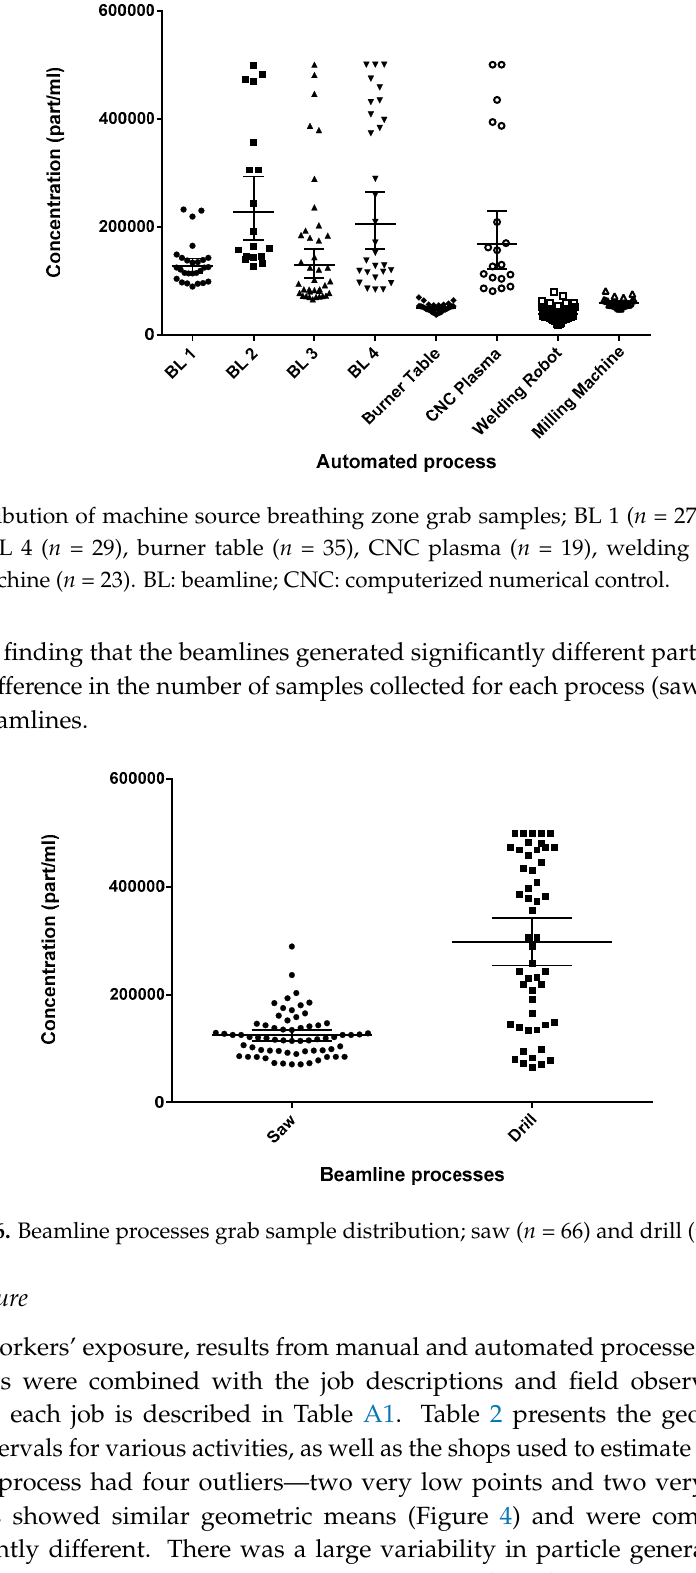
6 of 16 Figure 4. Manual task breathing zone grab samples; FCAW ( n = 30), SMAW ( n = 13), MCAW ( n = 42), grinding ( n = 33), gouging ( n = 20), and oxycutting ( n = 38). FCAW: flux cored arc welding; SMAW: shielded metal arc welding; MCAW: metal cored arc welding. 3.4. Machine Exposures Results for all of the machine operator samples are shown in Figure 5. As for manual tasks, each point represent the average of five readings taken over 5 s. A Kruskal–Wallis test demonstrated that the sources generated significantly different particle levels ( p < 0.0001). Using Dunn’s multiple comparison test, the beamlines were not different from CNC plasma cutting ( p > 0.99). The welding robot, milling machine, and burner table had very low particle generation; these levels were comparable to the median shop B/A background levels, and were significantly different than all other processes ( p < 0.005), but not significantly different from one another ( p > 0.1). A Kruskal–Wallis test on the four beamlines showed that they too generated significantly